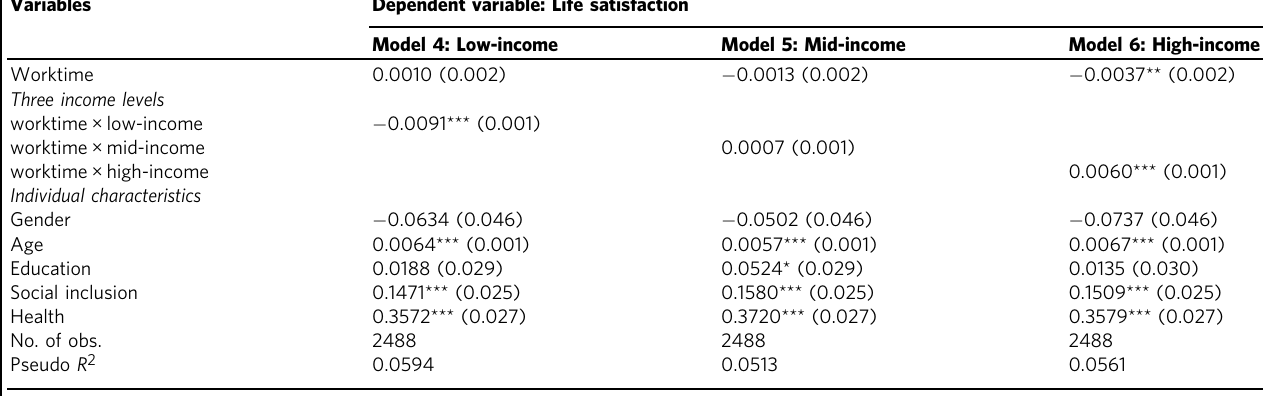
Table 2 Empirical analysis of the effect of worktime per week on self-reported life satisfaction at various income